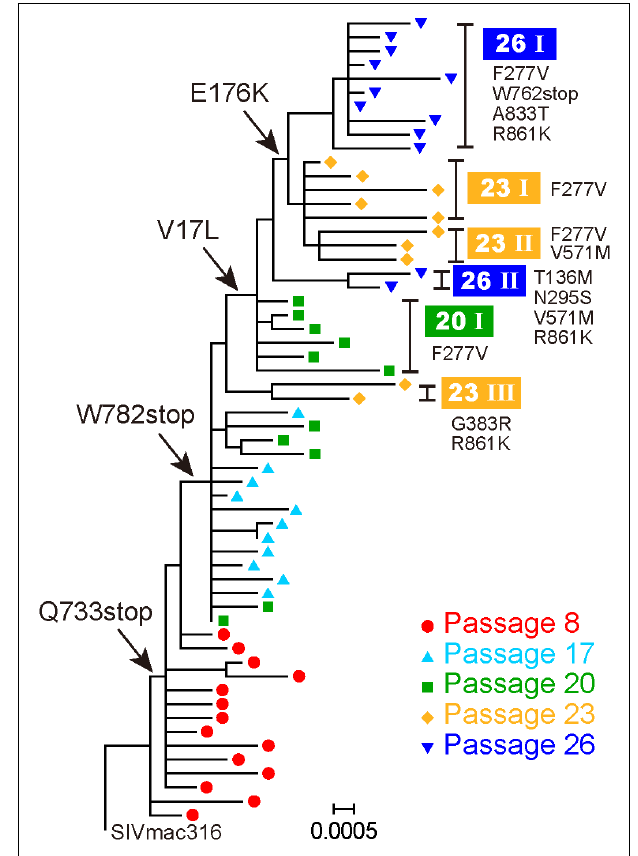
FIGURE 1 | Evolution of B404-resistant variants. Nucleotide sequences of the env gene, which were derived from proviruses at passages 8, 17, 20, 23, and 26, were phylogenetically analyzed using MEGA5. Arrows indicate major substitutions as follows: Q733stop,W782stop,V17L, and E176K. Clones with representative amino acid substitutions were separated into groups, which are shown on the right side along with the corresponding